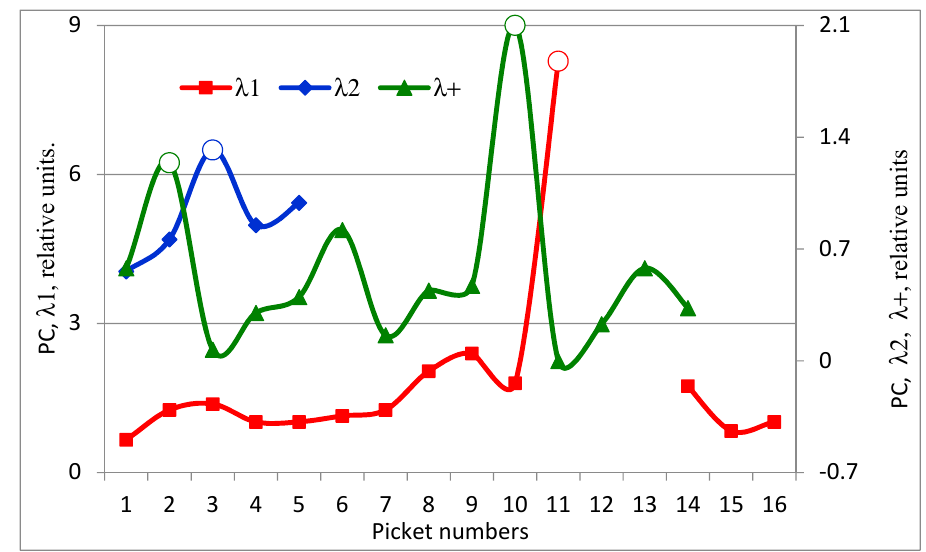
Figure 5. Variations in the polar conductivities of air during observations: on the profile in the “cross” with a line of subway metro— λ 1, metro Kon’kovo, observation step 4 m; on the profile in the “cross” with a deep underground line— λ 2, Metro University, observation step 12 m; on the horseshoe profile, twice crossing the karst cavity— λ + (Tula, Soyuzny lane), the observation step is 4– 12